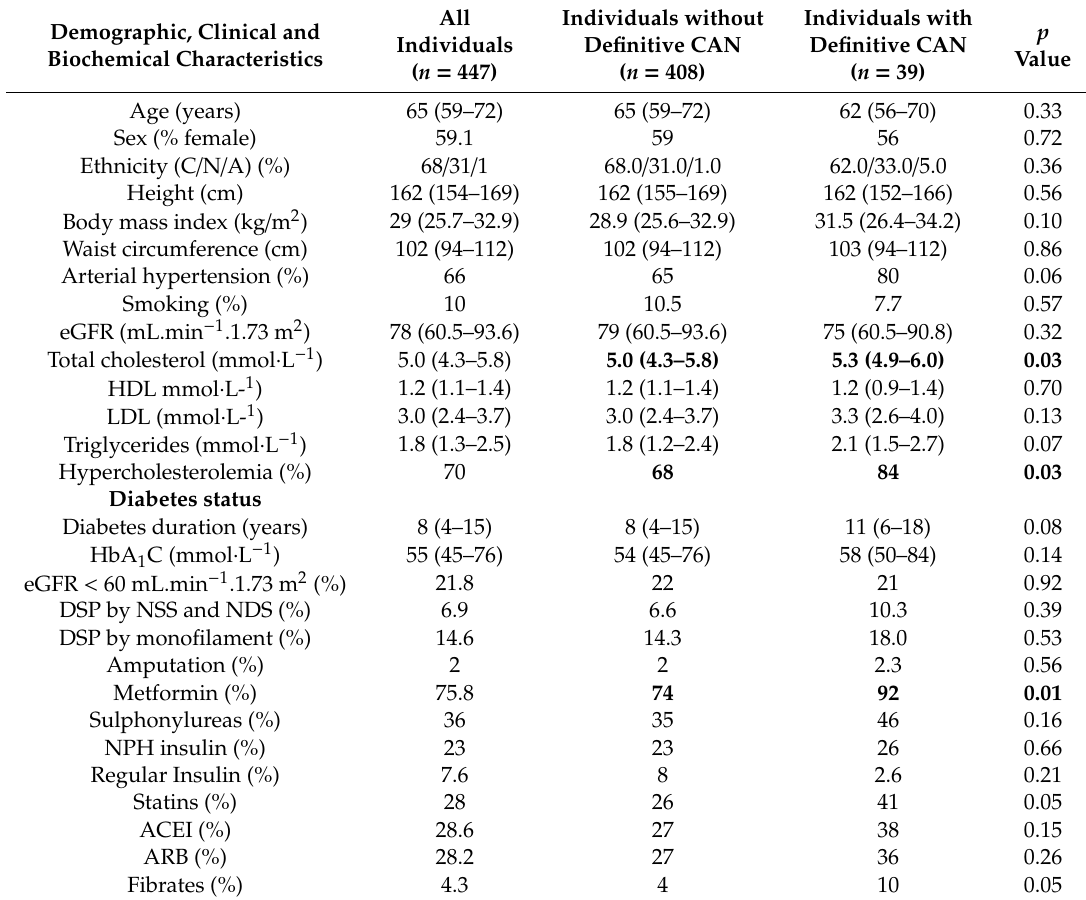
Table 2. Characteristics of individuals with type 2 diabetes according to the status of cardiovascular autonomic neuropathy